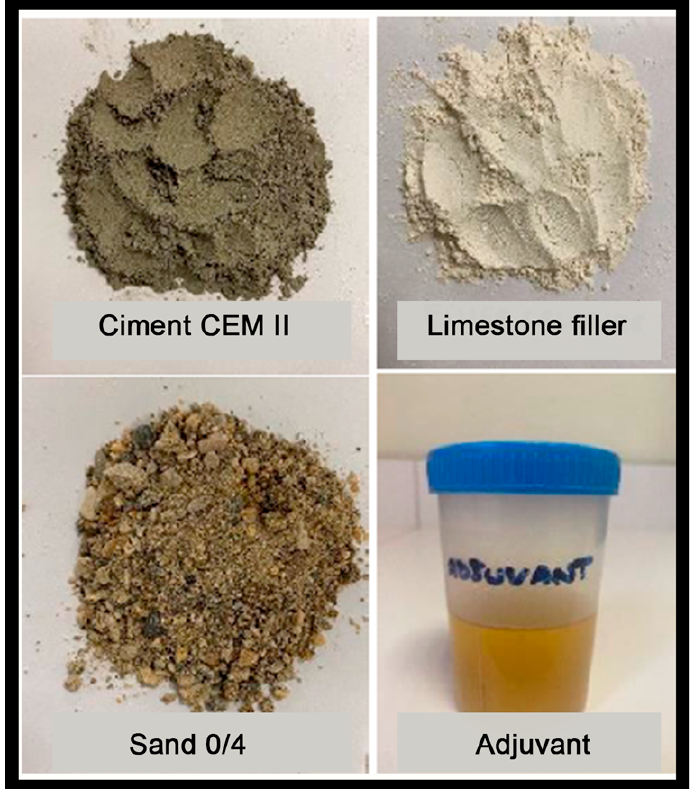
Figure 2. Materials used in the research.